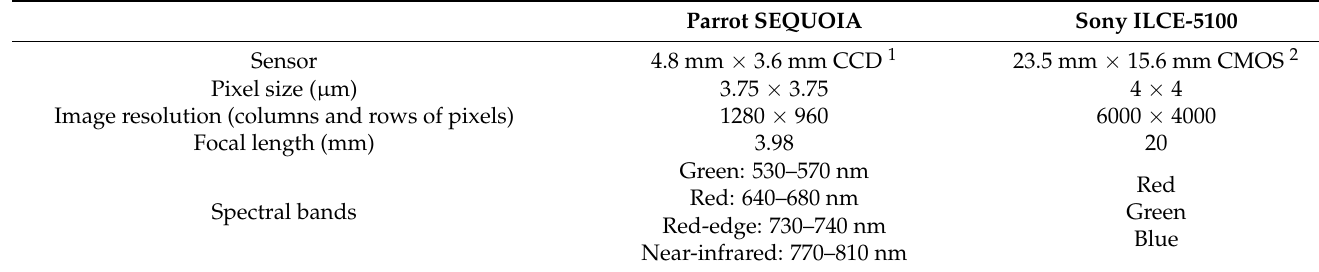
Table 3. Characteristics of the sensors mounted on the UAV flown in a vineyard cv. Monastrell, located in south-eastern Spain, in the 2018, 2019, and 2020 seasons.